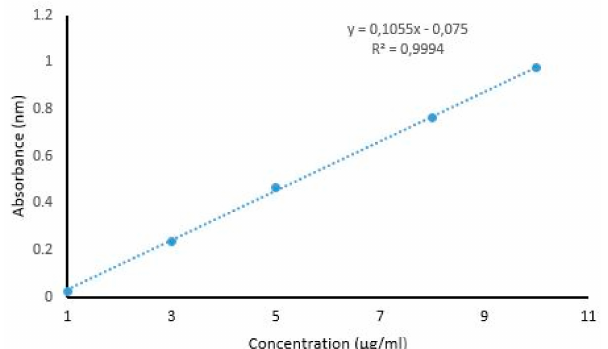
Figure 2. Calibration curve of HCT, undertaken for in vitro evaluation of the formulated samples.